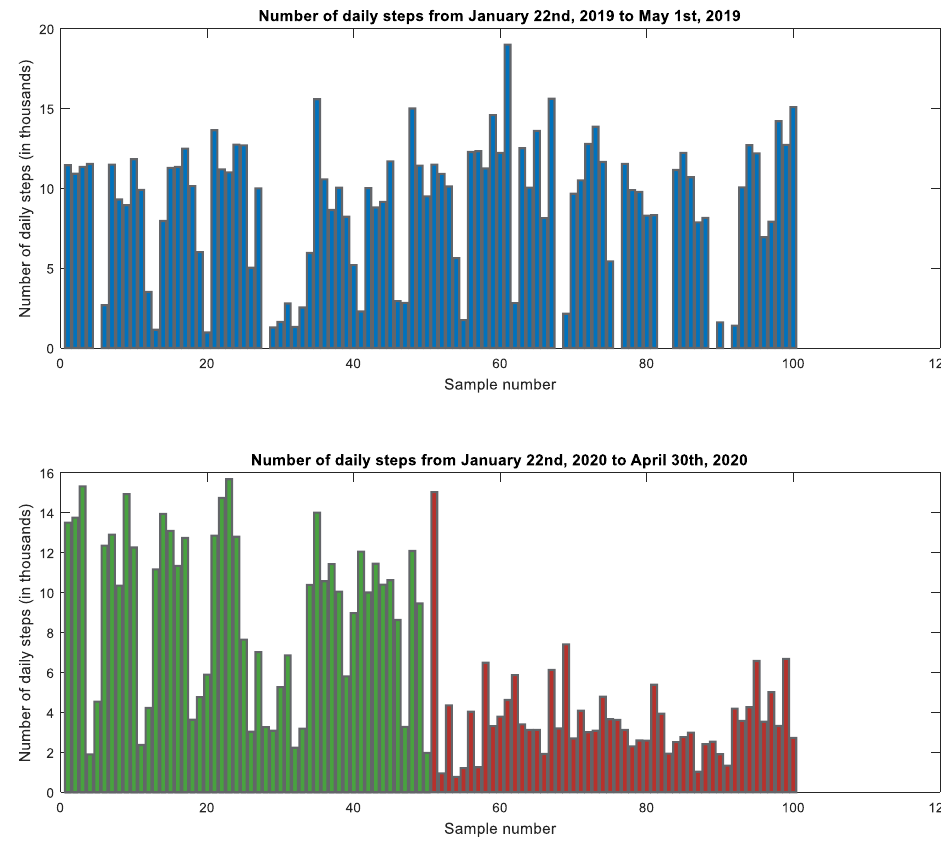
Figure 1. The number of daily steps in the analyzed intervals for Subject 1.